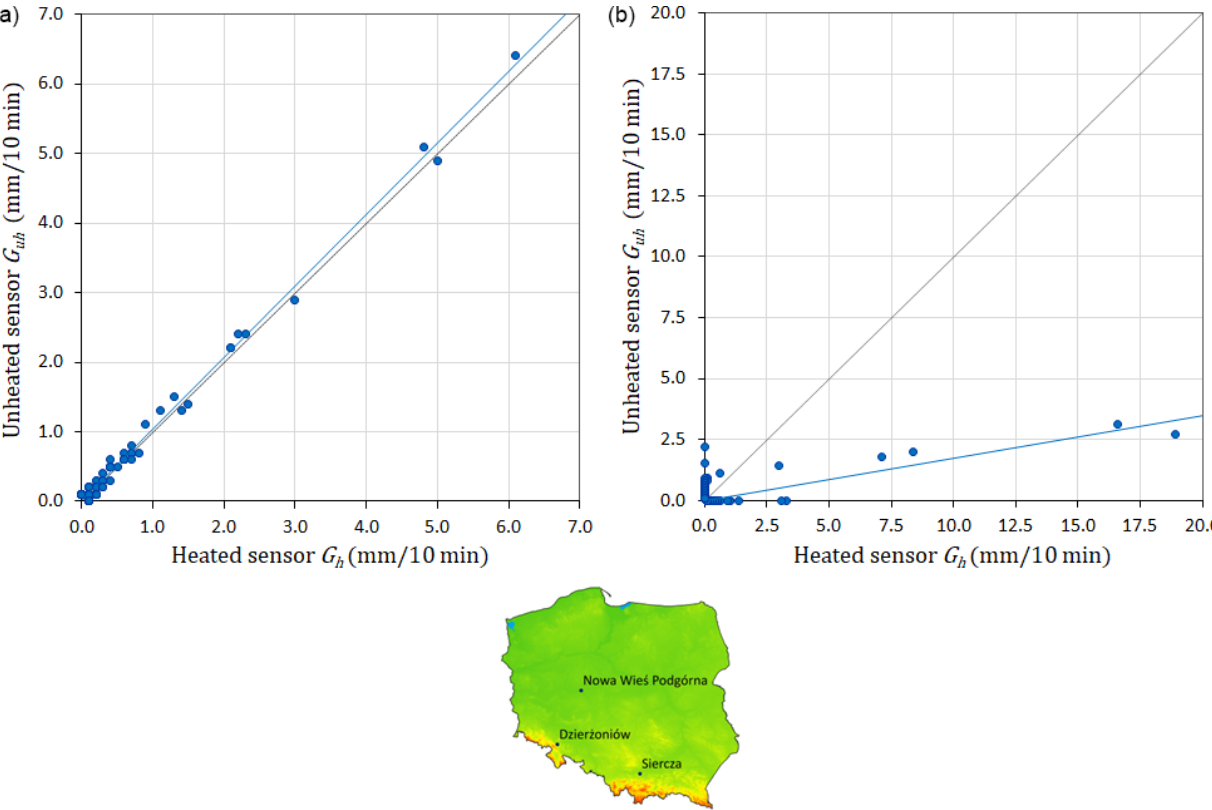
Figure 2. Relationships between observations of 10min precipitation accumulation measured with tipping bucket rain stations equipped with two sensors – unheated and heated – in Dzier˙zoniów during July 2021 (a) and in Nowa Wie´s Podgórna during June 2021 (b) . The blue lines mark the trends of these relationships. The data from three rain stations shown in the bottom map are discussed in the